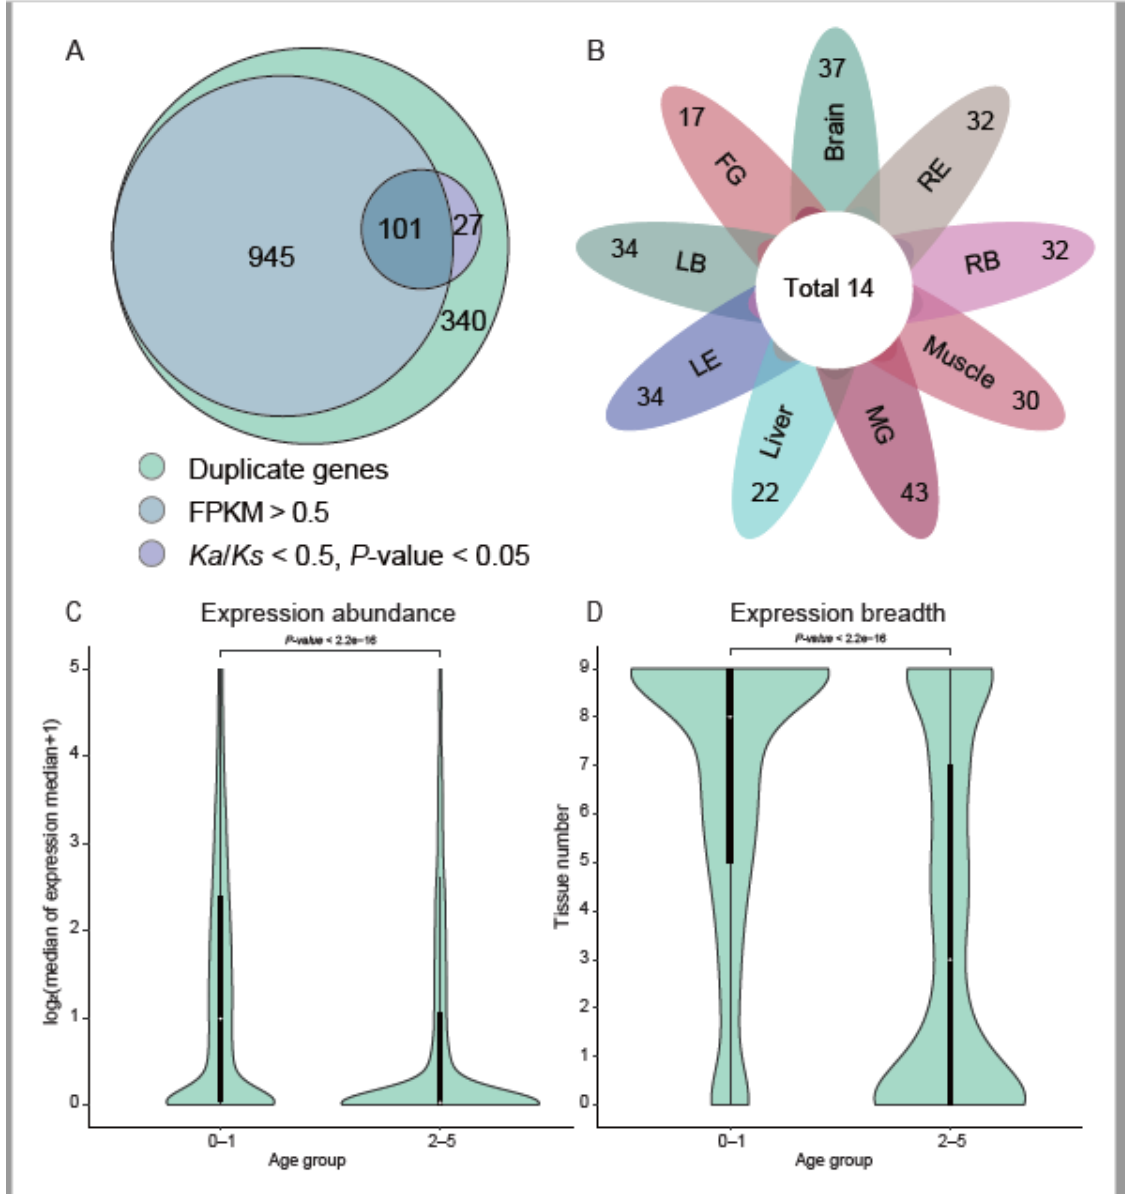
Figure 2. Expression of new genes. ( A ) Expression evidence of new genes. New genes with evidence of expression mean expressed in at least one tissue (FPKM > 0.5). Genes with significant paralog Ka / Ks < 0.5 are 128 (101 + 27). ( B ) Expression of de novo genes in different tissues. Each petal represents the number of genes expressed in the tissue (left-eye type’s tissues around eyes (LB), left-eye type’s two eyes (LE), right-eye type’s tissues around eyes (RB), right-eye type’s two eyes (RE), female gonad (FG), male gonad (MG). Fourteen de novo genes are expressed in all the studied tissues. ( C , D ) show violin plots of expression abundance and breadth of Pleuronectoidei-specific genes across indicated age groups (log2-based median of the median expression in 9 starry flounder tissues and the numbers of tissues where genes are expressed (FPKM > 0.5). In each case, the violin curve indicates the probability density of the data, the black bar in the center shows the interquartile range and the white dot shows the median. The genes were divided into two age groups. Results of Wilcox tests of the significance of differences between the age groups are also presented.